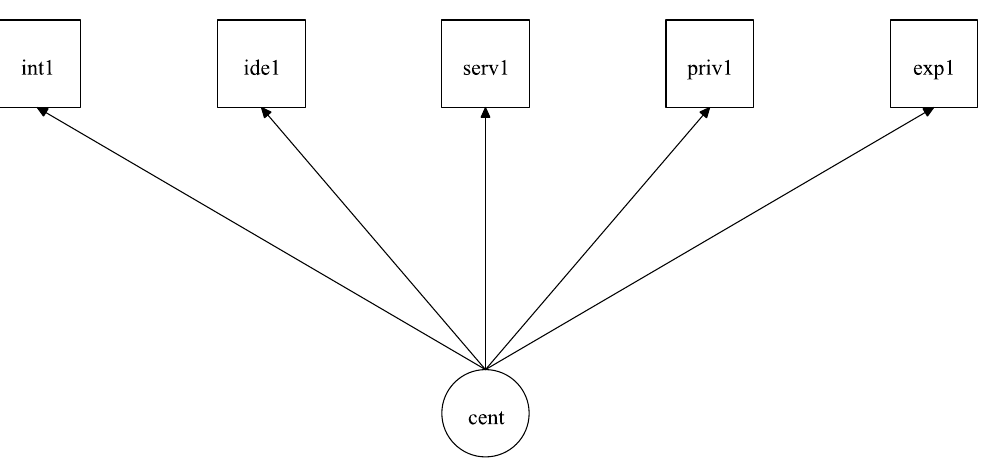
Figure 1. The confirmatory factor analysis model for the CRS-5. int = intellect; ide = ideology; serv = public practice; priv = private practice; exp = experience. The number after the item name indicates the position of the item within the core dimension items. Squares depict manifest and circles latent variables. Residual arrows are not shown for the manifest variables.